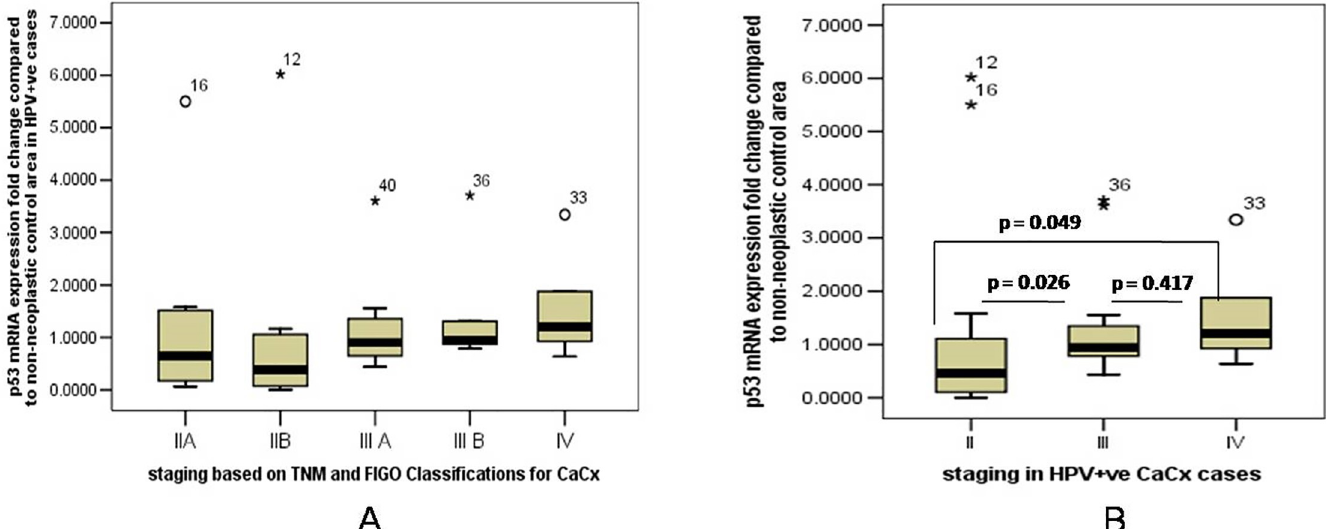
Fig 2. [A] Box plot analysis showing differential p53 mRNA expression in HPV positive cases showing downregulation in lower severity stage (stage IIA and Stage IIB) compared to higher stages of Cervical cancer ( � stage III) as per the TNM and FIGO staging of cervical carcinoma. [B] Box plot showing differential p53 mRNA expression analysis in stage II III and IV of HPV positive cervical cancer